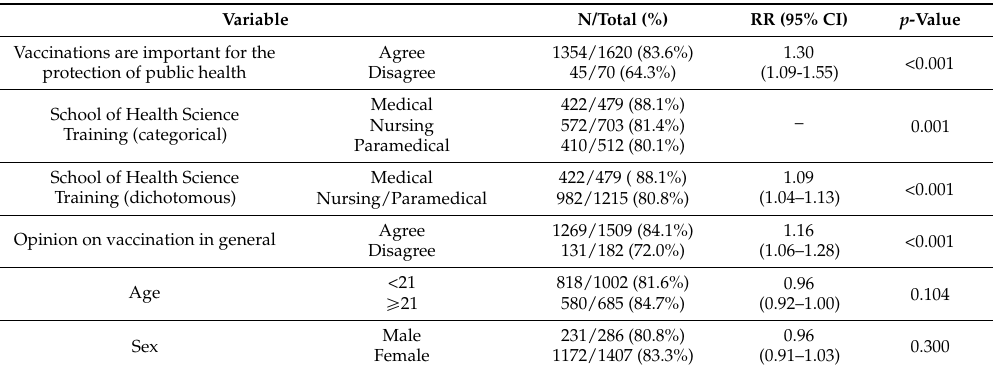
Table 2. Univariate analysis of vaccination with HBV